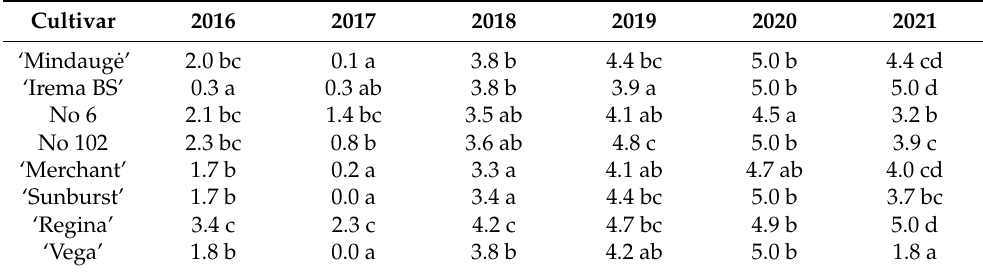
Table 1. Sweet cherry flowering abundance (0–5 score scale). Values marked with different letters are statistically different within the columns ( p ≤ 0.05).